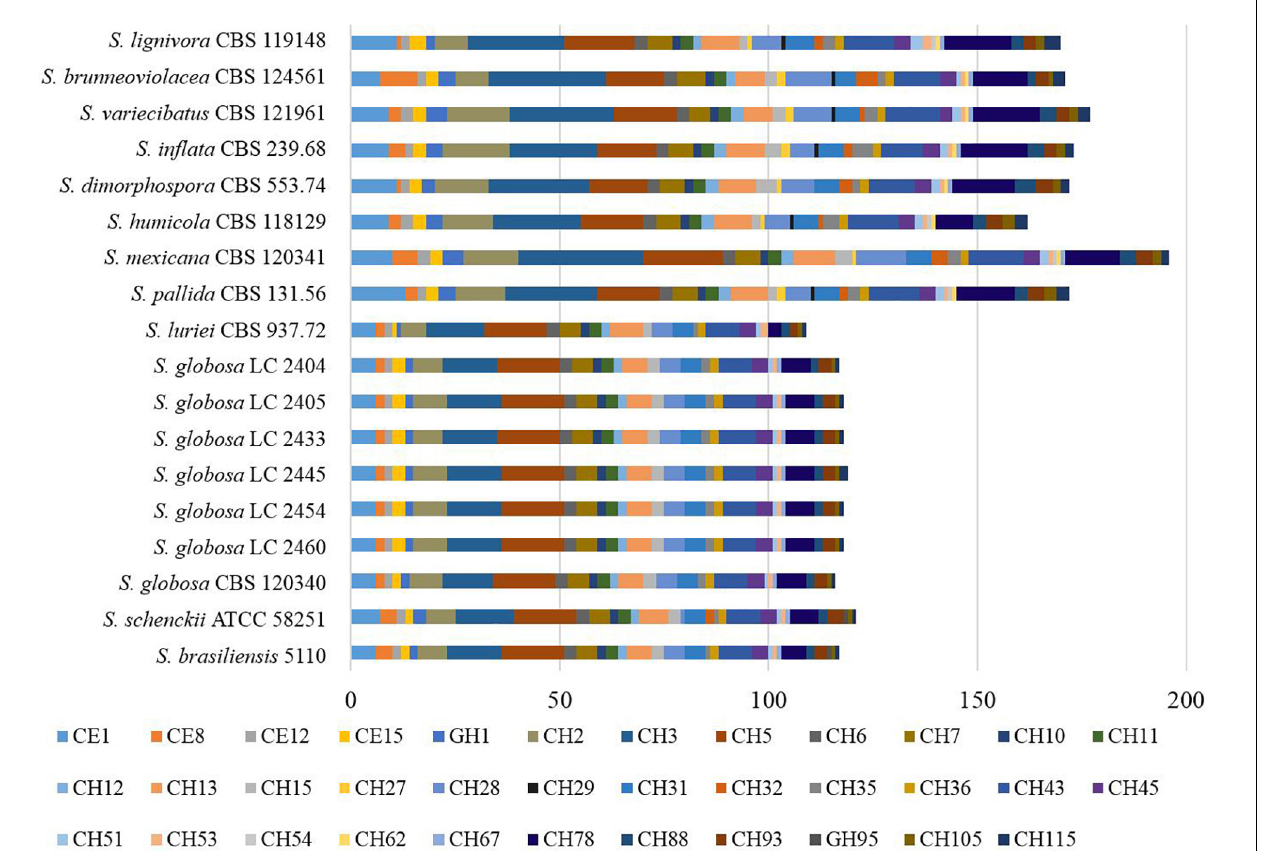
FIGURE 5 | Counts of the putative genes involved in plant polysaccharide degradation in the genus Sporothrix. The major plant polysaccharide degradation (PPD) enzyme genes in the four main clinical species ( S. brasiliensis , S. schenckii , S. globosa, and S. luriei ) were less than those of the environmental and other clinical